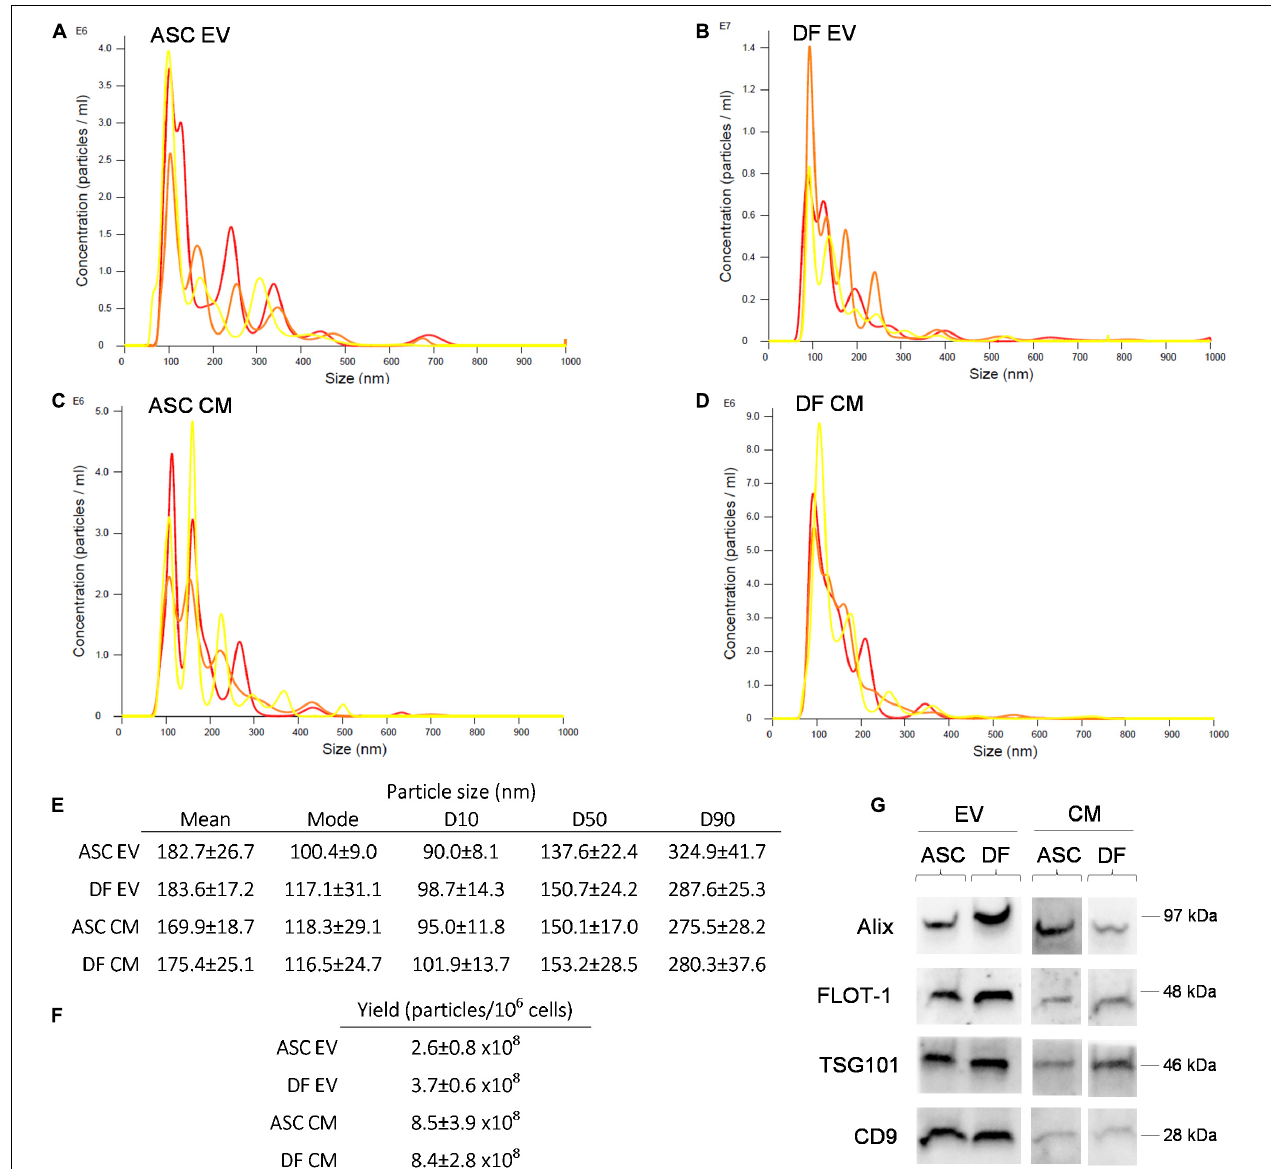
FIGURE 1 | (A–D) Representative NTA of EV and CM samples derived from ASCs and DFs. Each graph shows the size distribution of 3 consecutive 1 min runs for each sample. (E–F) Size distribution and vesicular yield deriving from 6 NTA measurements/group shown as mean ± SD. (G) Western Blot of CM and EV samples from ASCs and DFs, showing the expression of the vesicular markers Alix, FLOT-1, TSG101 and CD9. In each lane, 10 µ g of CM or EV deriving from 1.5 × 10 6 cells were